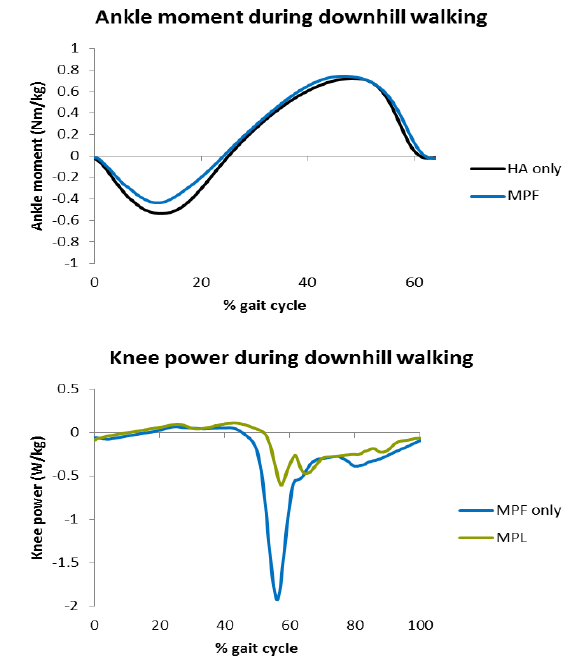
Figure 1: (TOP) ankle moment curves showing the effect of MPF (blue) compared to HA (black) and (BOTTOM) knee power curves showing the effect of MPL with knee yielding (green) compared to MPF only